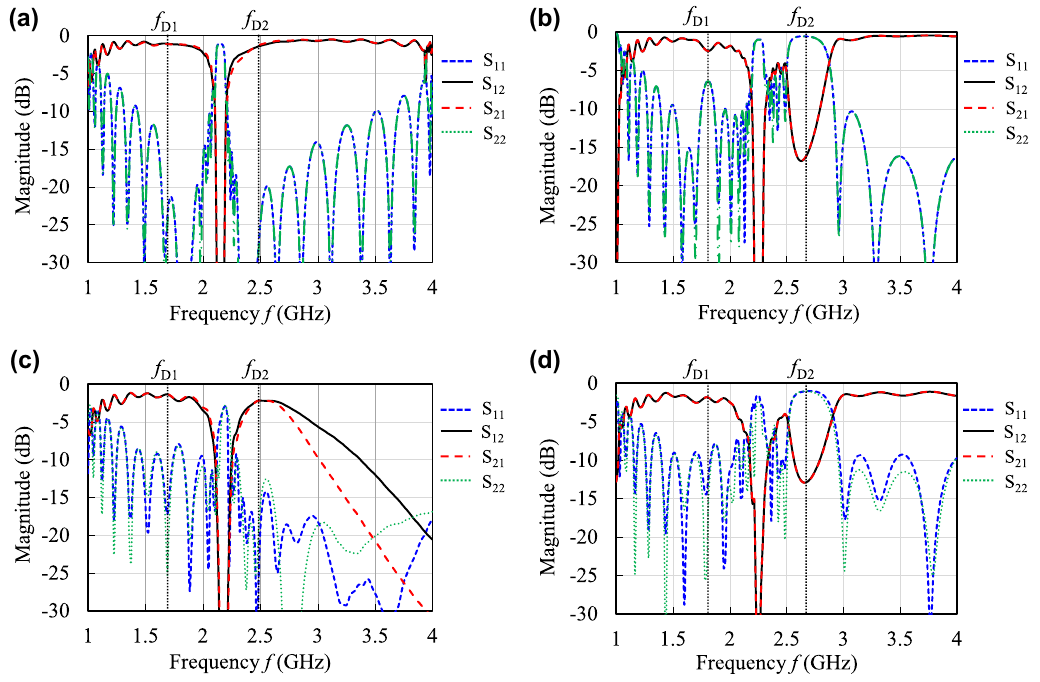
Figure 6: Magnitudes of transmission and reflection coefficients of the designed and fabricated CRLH lines. (a) and (b) denote numerical simulation results for nonreciprocal and almost reciprocal cases, respectively. (c) and (d) represent the measurement results corresponding to (a) and (b), respectively. (a) The internal dc fi eld μ 0 H 0 = 140 mT. (b) μ 0 H 0 = 400 mT. (c) The external dc magnetic fi eld μ 0 H ext = 300 mT. (d) μ 0 H ext = 520